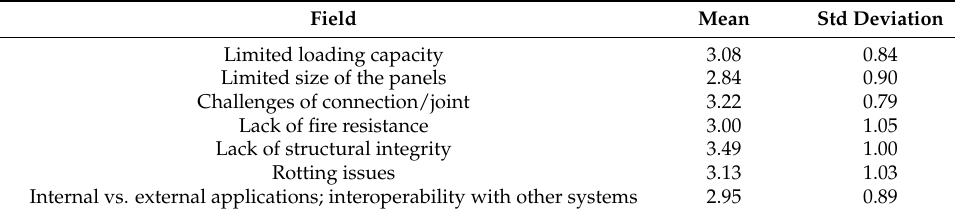
Table 4. Technical and performance limitations for